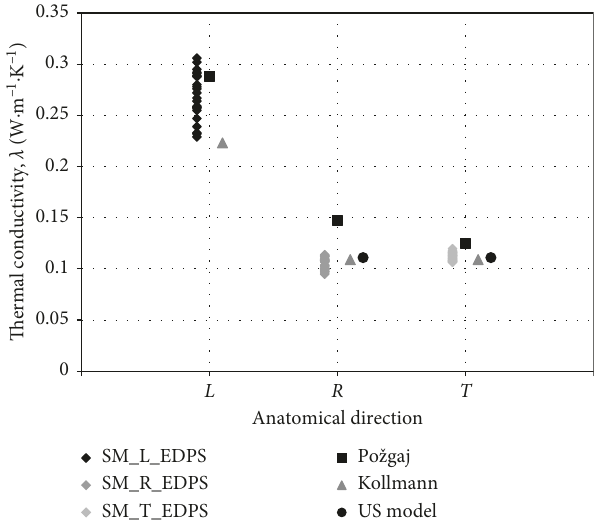
Figure 2: Thermal conductivity as a function of the anatomical direction in Norway spruce (at the moisture content of 12%).